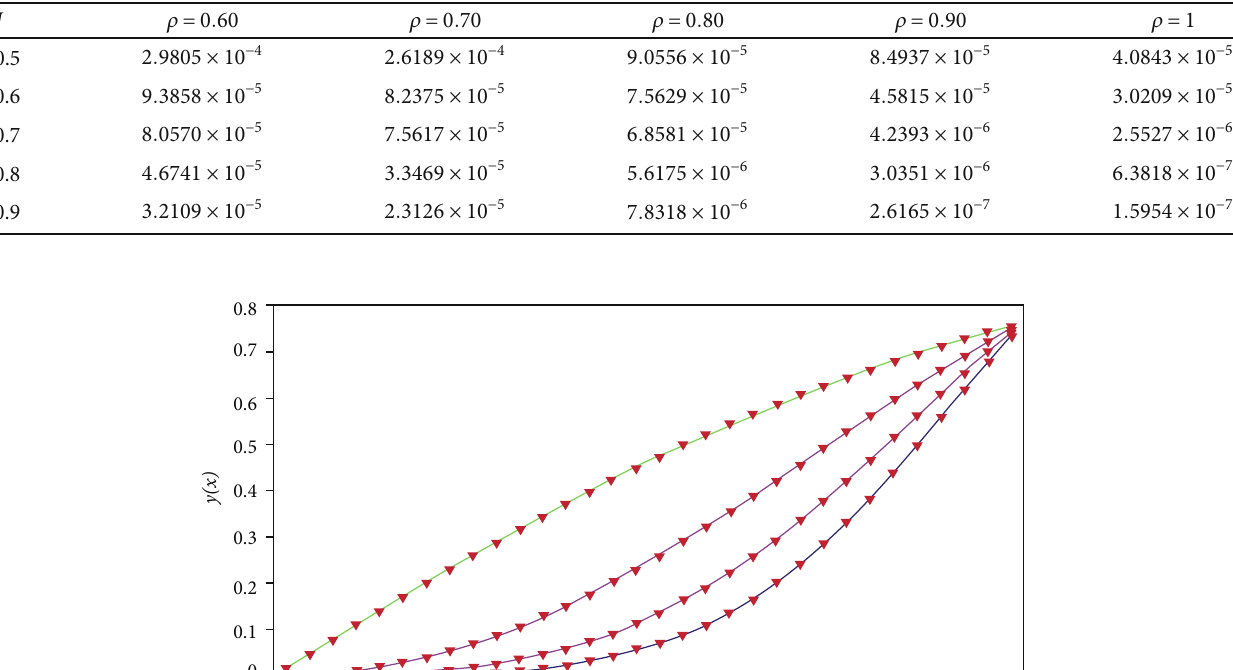
Table 4: Maximum absolute error for φ ð ζ Þ = ζ 3 and various choices of J and ρ .